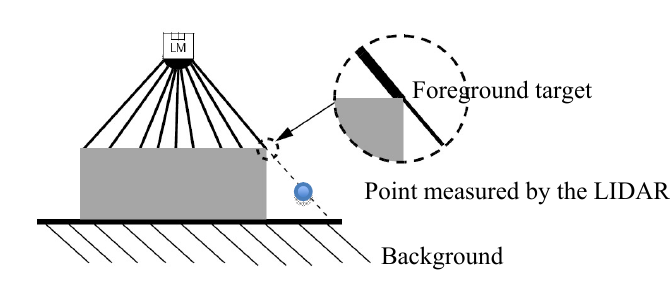
Figure 4. The edge effect produced when a beam partially falls on the edge of a target [16]. In this case the LIDAR sensor provides an intermediate range between the foreground and